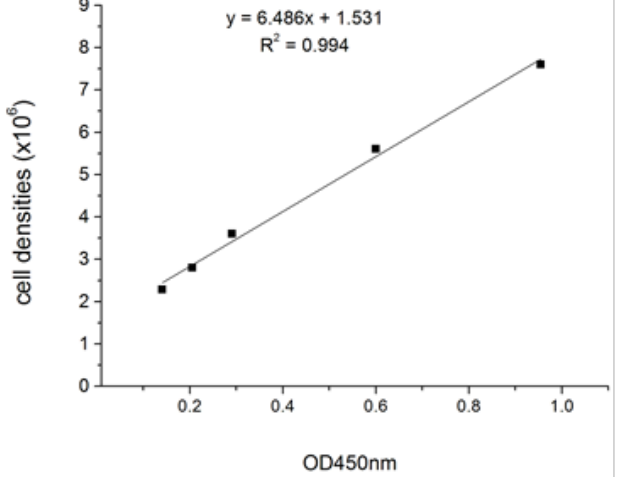
Figure 1. The standard curve between OD450 and C. pyrenoidosa ZF strain cell densities.